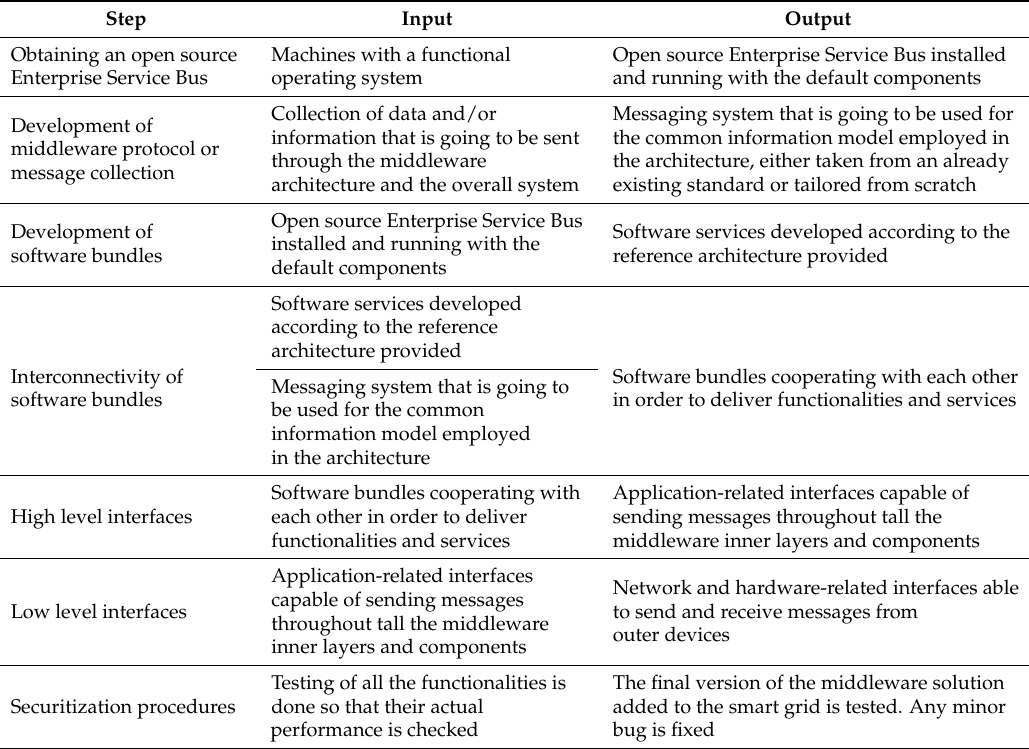
Table 4. Middleware architecture development